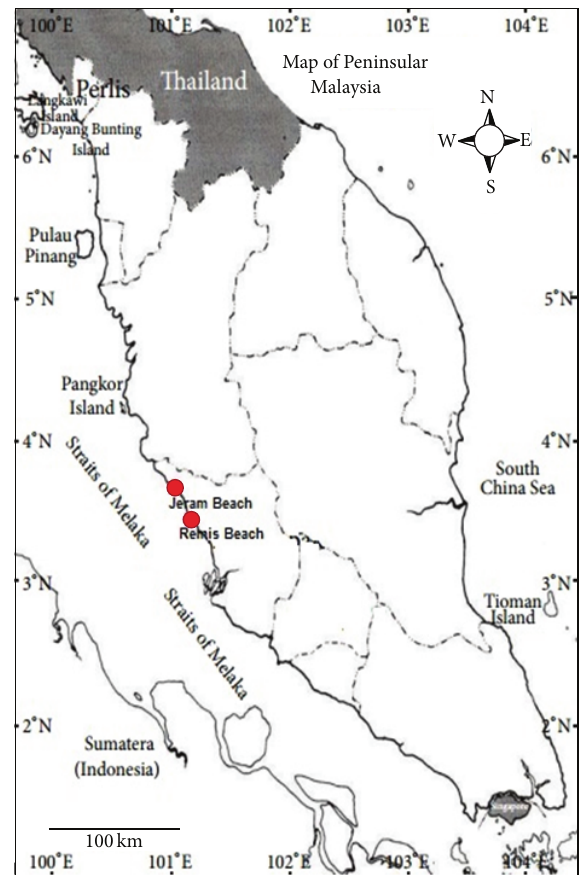
Figure 1: The Coastal Mudflats of Jeram and Remis Beaches, Selangor, West Coast of Peninsular